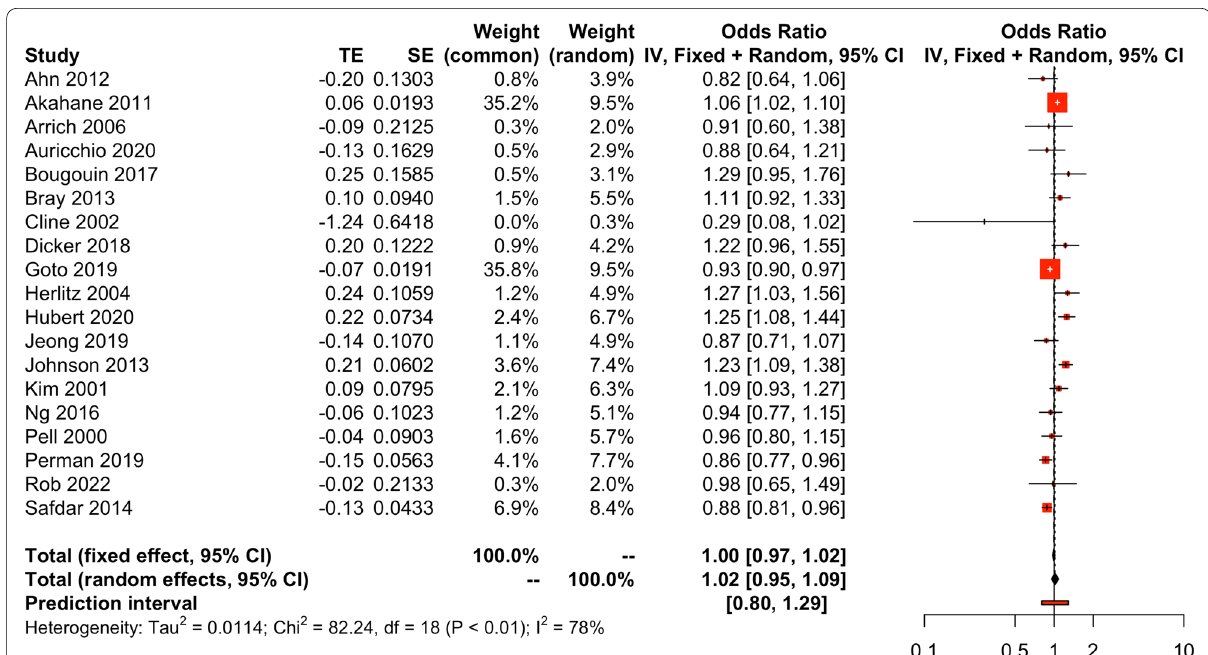
Fig. 3 Forest plot of adjusted data on male and female survival to discharge or to 30 days after